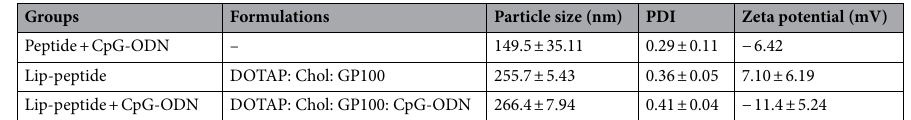
Table 1. DLS analysis. Characterization of peptide and cationic liposome formulations. All data of vesicle size, Polydispersity, and zeta potential represent Mean ± SD (N=3). Polydispersity, and zeta potential represent Mean ± SD